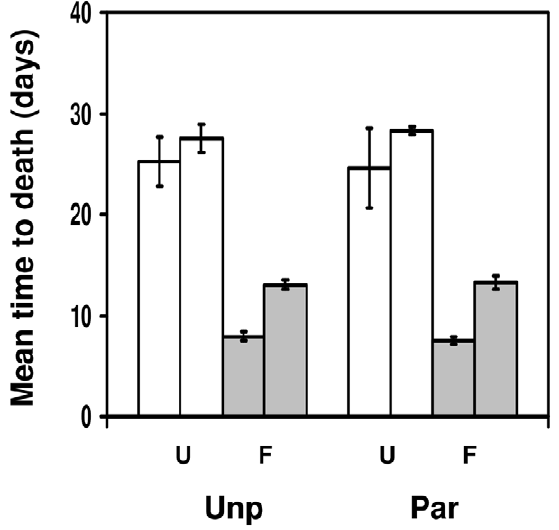
Figure 1. Fungal resistance of flies surviving parasitism. Mean time to death (in days) for Drosophila melanogaster adult flies that were either infected with Beauveria bassiana (F; grey bars) or uninfected (U; white bars), depending on whether they had been parasitised by Asobara tabida as a larvae (Par; right side of panel) or had not been parasitised (Unp; left side of panel). The two bars within each treatment combination represent the results of the two experimental blocks. Bars show mean 6 s.e.